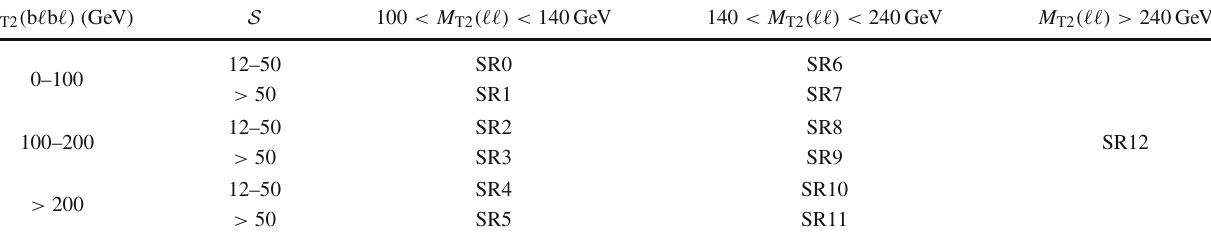
Table 3 Definition of the signal regions. The regions are further split into SF and DF regions. The preselection in Table 2 is applied to all regions